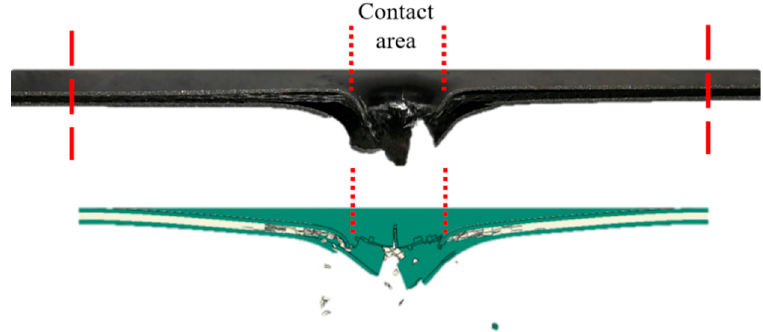
Figure 11. Cross sectional damage surface of the TFML-2/1.